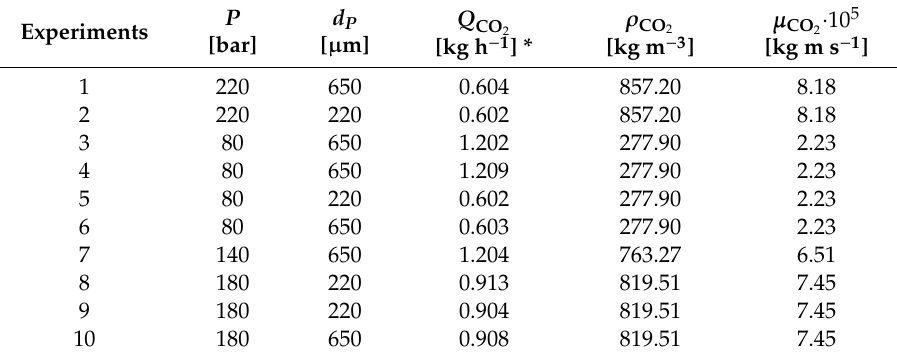
Table 1. Conditions of supercritical fluid extraction.